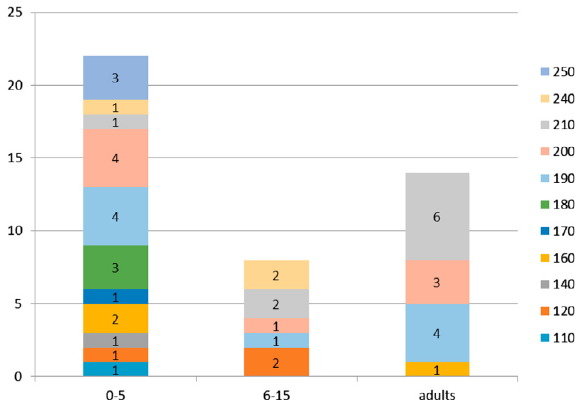
Figure 5. Mad20 allele distribution according to age